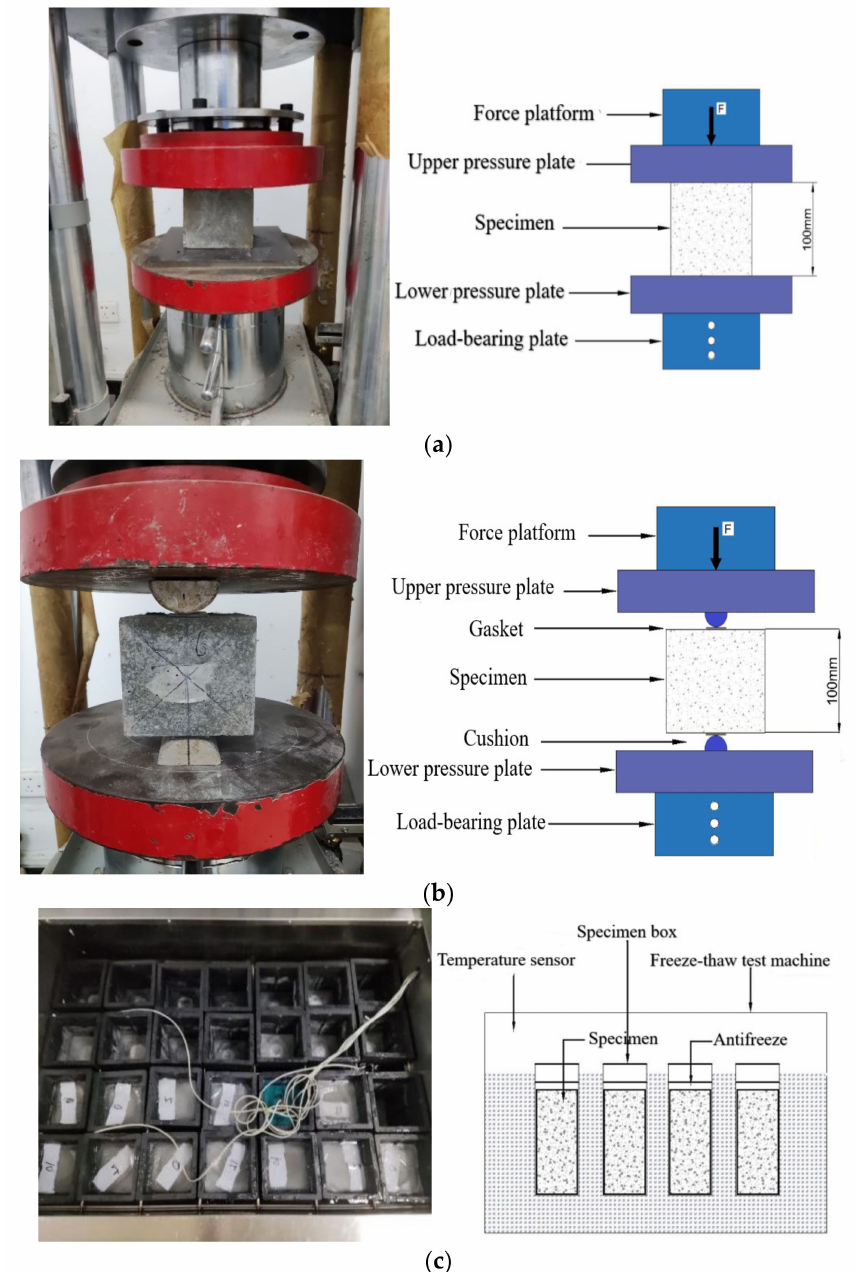
Figure 3. Testing device: ( a ) Compression test, ( b ) Flexural strength test, ( c ) Freeze–thaw cycle